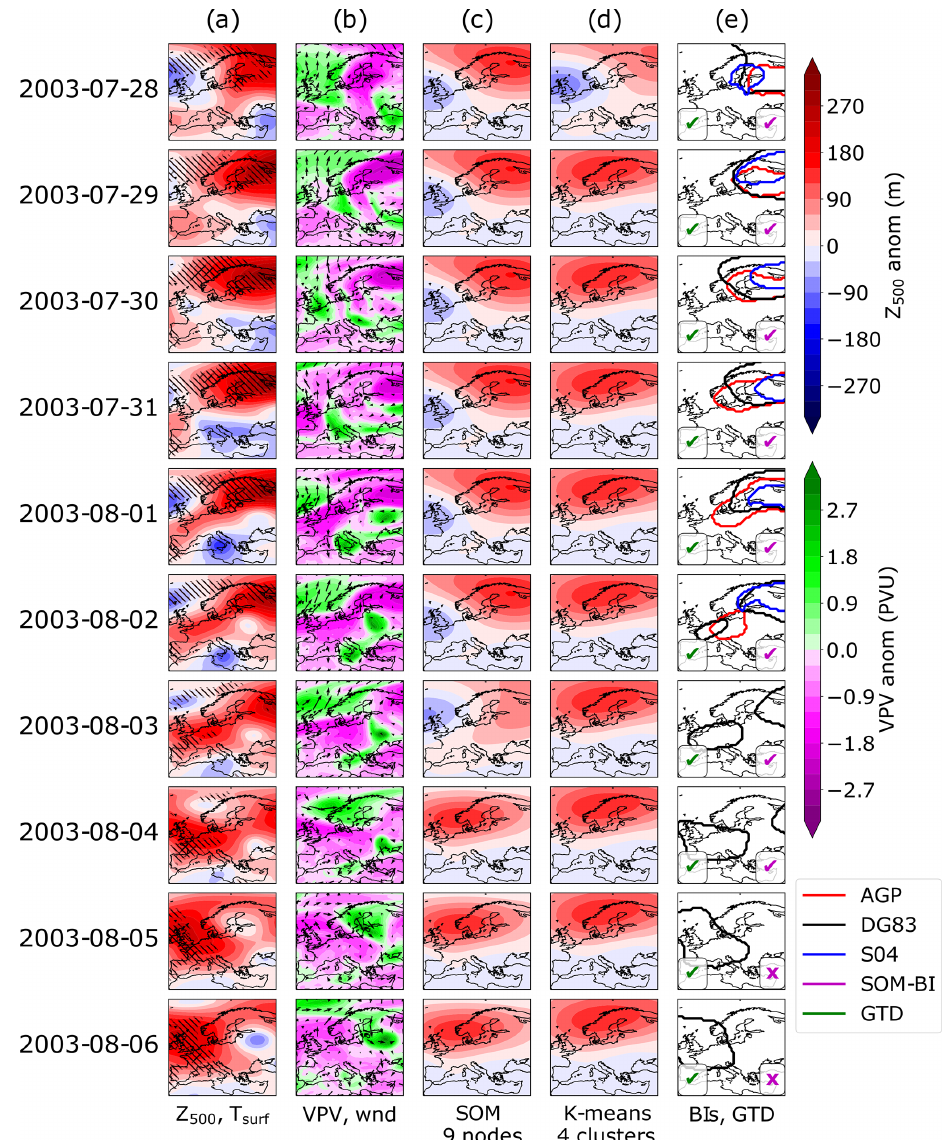
Figure 5. The 2003 European heat wave. Column (a) shows the detrended 500hPa geopotential height anomaly for each day. Left (right) hatching indicates where the local surface temperature exceeds the 90th (99th) percentile for the detrended 2m temperature. Column (b) shows the potential vorticity anomaly vertically averaged across 150–500hPa, with arrows showing the 10m wind field. Column (c) shows the corresponding SOM pattern for Z 500 anomalies from nine nodes. Column (d) similarly shows the corresponding K -means centroid for four clusters. Column (e) shows the contours identified as blocked in this region in the AGP (red), DG83 (black) and S04 (blue) indices. A green (magenta) tick or cross indicates if the GTD (SOM-BI) identifies the day as blocked or